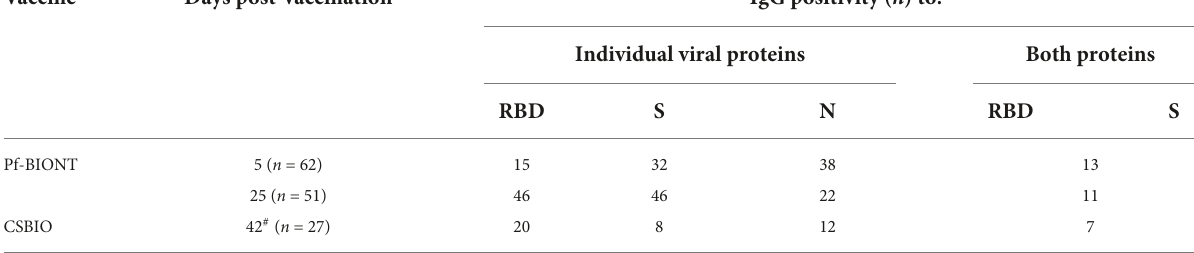
TABLE 2 Number of individuals showing IgG reactivity against the SARS-CoV-2 antigens RBD, S, and N in serum collected from Pf-BNT and CSBIO vaccine recipients. Vaccine Days post-vaccination IgG positivity ( n ) to: Individual viral proteins Both